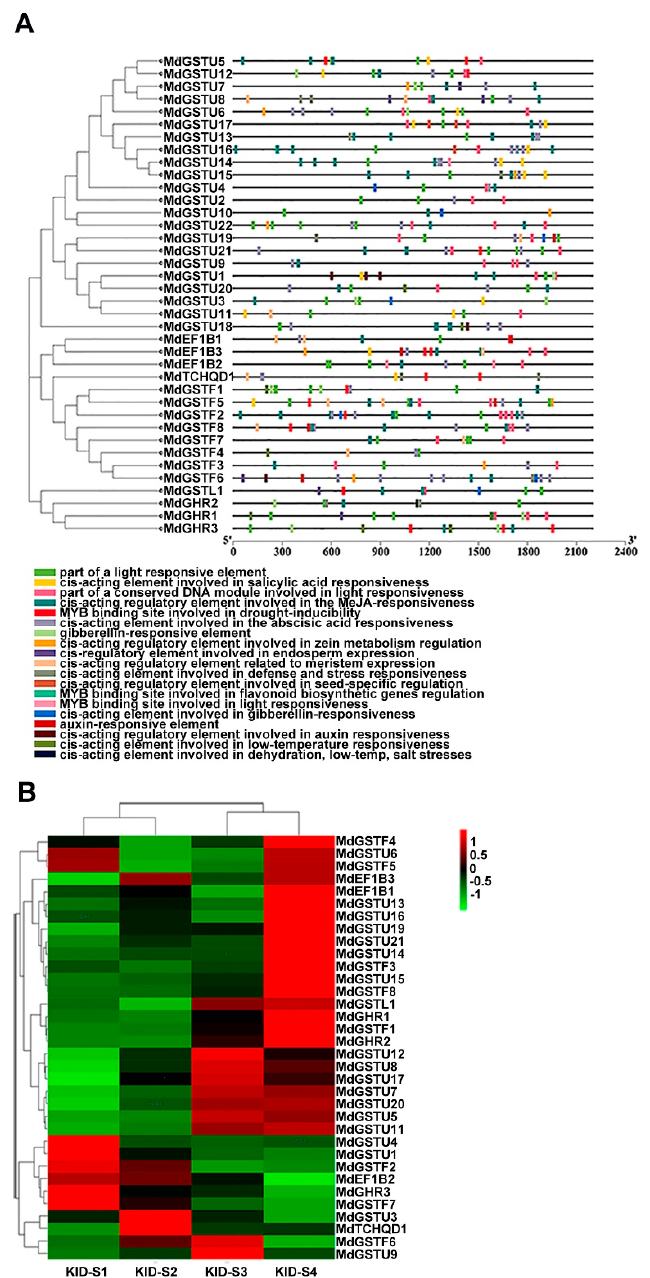
Figure 3. The main cis -acting elements in MdGST promoters and expression patterns of MdGST genes during fruit development. ( A ) Promoter analysis was performed on 2000-bp sequences upstream of the transcription start sites. ( B ) KID-S1 (85 days after flowering), KID-S2 (107 days after flowering), KID-S3 (128 days after flowering), and KID-S4 (145 days after flowering) represent the four main stages of anthocyanin accumulation during fruit developmental stages, KID represents the ‘Gala’ strain. The color in the Figure 3B indicates the expression level, which is the normalized value of pHeatmap in R language of Log 2 FC. The deeper the red is, the higher the expression is. The deeper the green is, the lower the expression